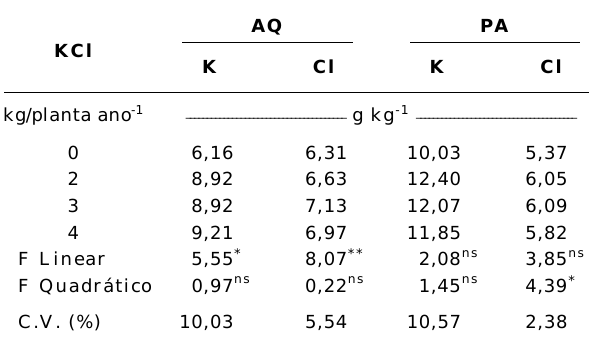
Figura 3. Número de frutos/planta ano -1 (Fr = n ) e teores de P na folha 14 do coqueiro (PFo = ), em função das doses de superfosfato simples no Podzólico Amarelo. *, ** significativo a 5 e 1%, respec-